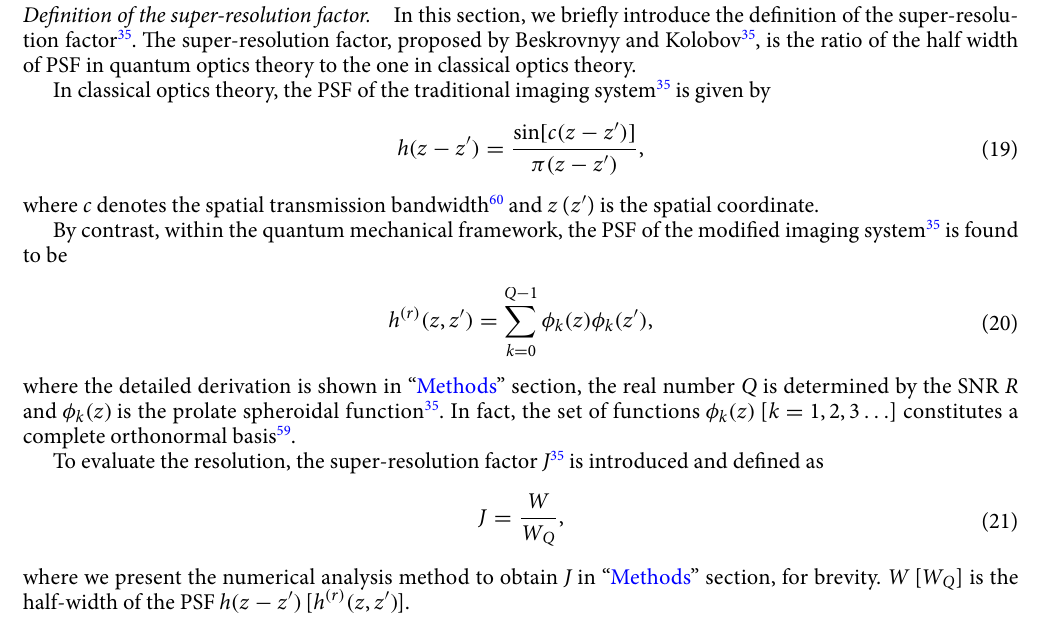
N . 0 � in D (α) S (ζ) ˆ | � = [ ˆ | �] ⊗